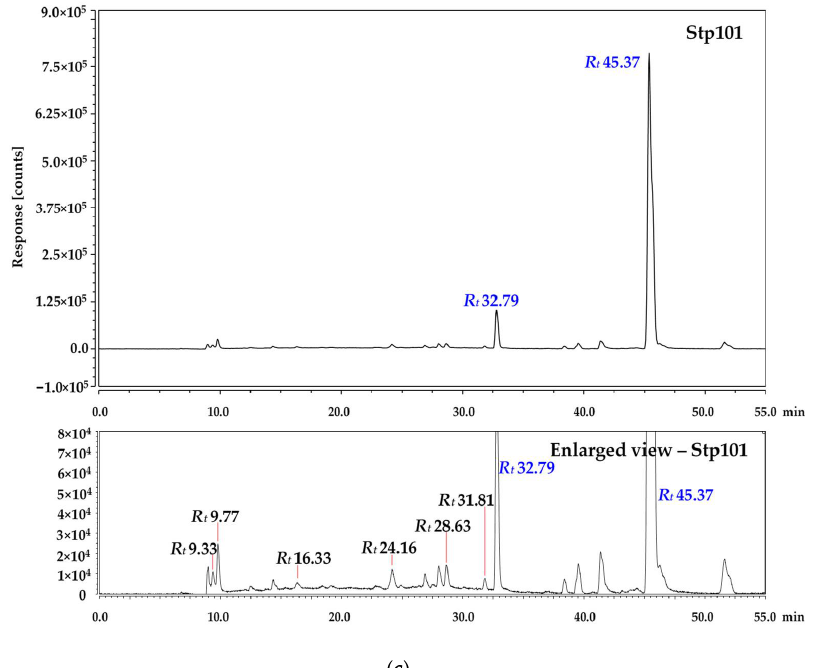
Figure 4. HPLC chromatographic profiles of red pigments extracted of G. arilaitensis strains, including ( a ) Re117, ( b ) Po102, and ( c ) Stp101.